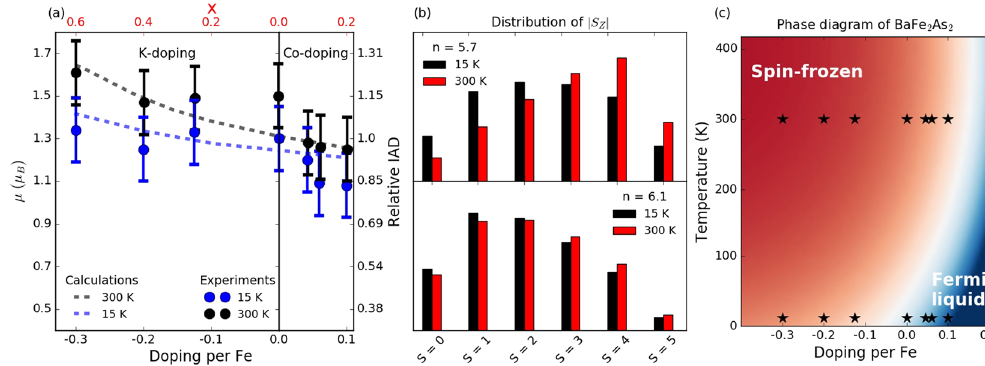
Figure 4. ( a ) Evolution of μ bare and relative IAD for Ba 1 − x K x Fe 2 As 2 and Ba 1 − x K x Fe 2 As 2 . The blue dots with error bars indicate measurements at 15 K, while the black dots with error bars represents μ bare at 300 K. The dashed coloured lines are values for μ obtained from the DMFT calculations. The relative IAD scale is set to unity for BaFe 2 As 2 at 15 K. ( b ) Distribution of | S z | values (in units of 1/2) in the thermal ensemble for n = 5.7 (top) and n = 6.1 (bottom) at 15 and 300 K. ( c ) Sketch of the theoretical phase diagram for Ba 1 − x K x Fe 2 As 2 and Ba 1 − x K x Fe 2 As 2 displaying the spin-frozen and Fermi liquid regimes and their evolution with doping and